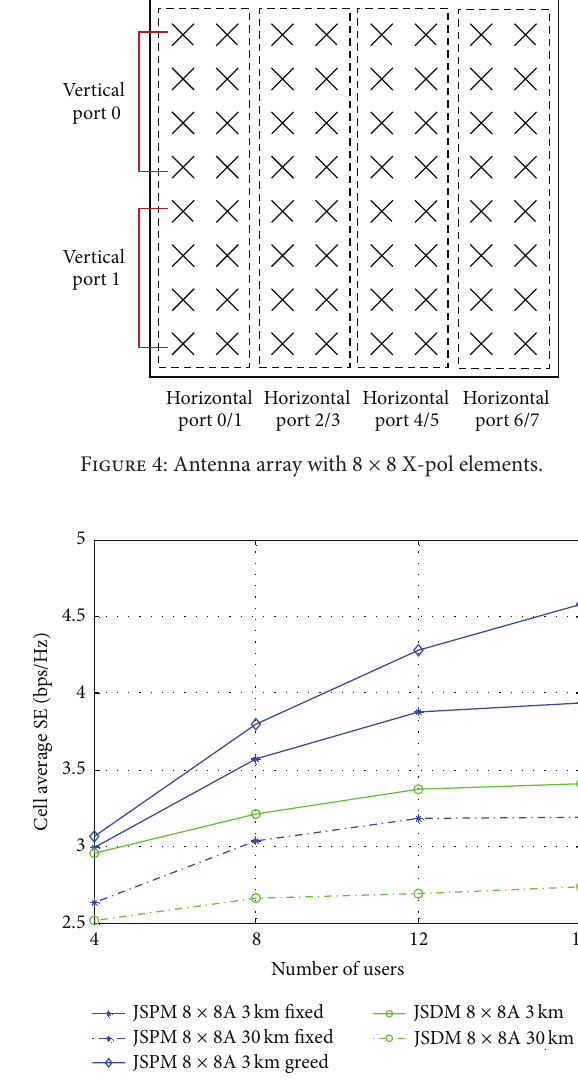
Figure 5: Cell average spectrum efficiency (SE) comparison with different user numbers per